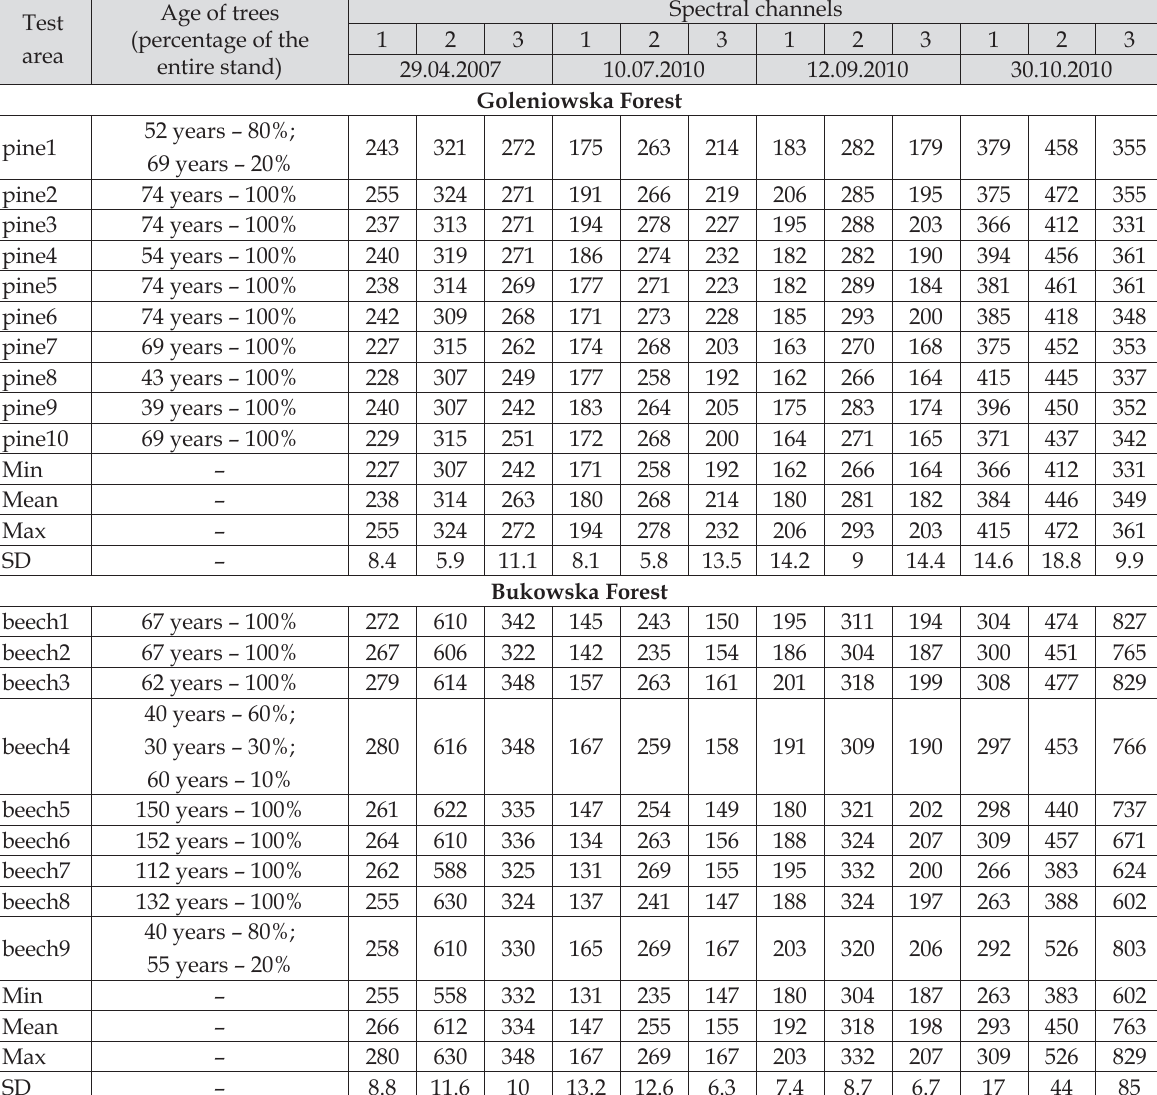
Table 1. Values for spectral reflectance [SRFI] of visible radiation (channels 1, 2 and 3) for beech and pine stands at various points of the vegetation